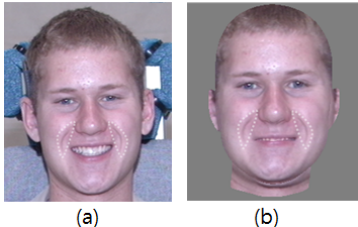
Figure 9. Remaining wrinkles after expression synthesis process: ( a ) Input image. ( b ) Expression synthesized